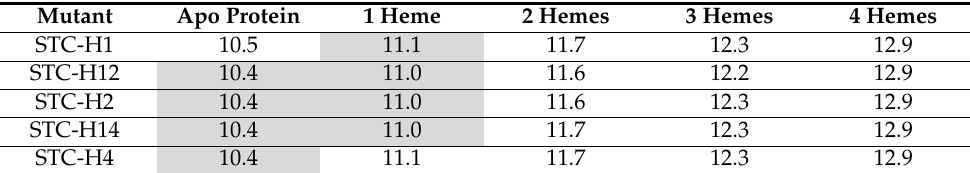
Table 1. Expected molecular weight (kDa) for the different STC mutants, determined from the molecular mass of the total number of residues plus the molecular mass corresponding the heme group(s) (616.5 Da per heme). Grey shading represents the species detected by mass spectrometry. Mutant Apo Protein 1 Heme 2 Hemes 3 Hemes 4 Hemes STC-H1 10.5 11.1